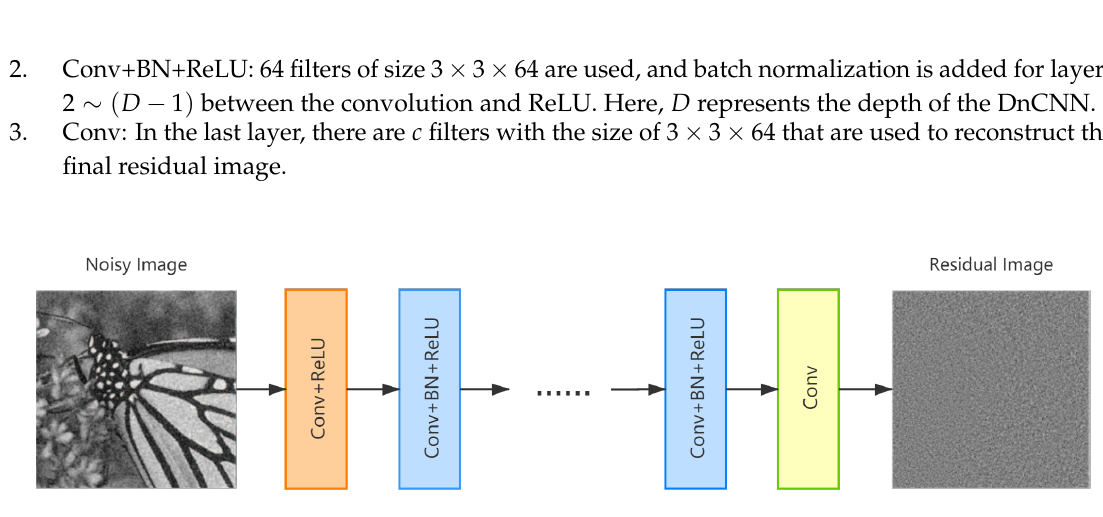
Figure 2. The architecture of DnCNN network.